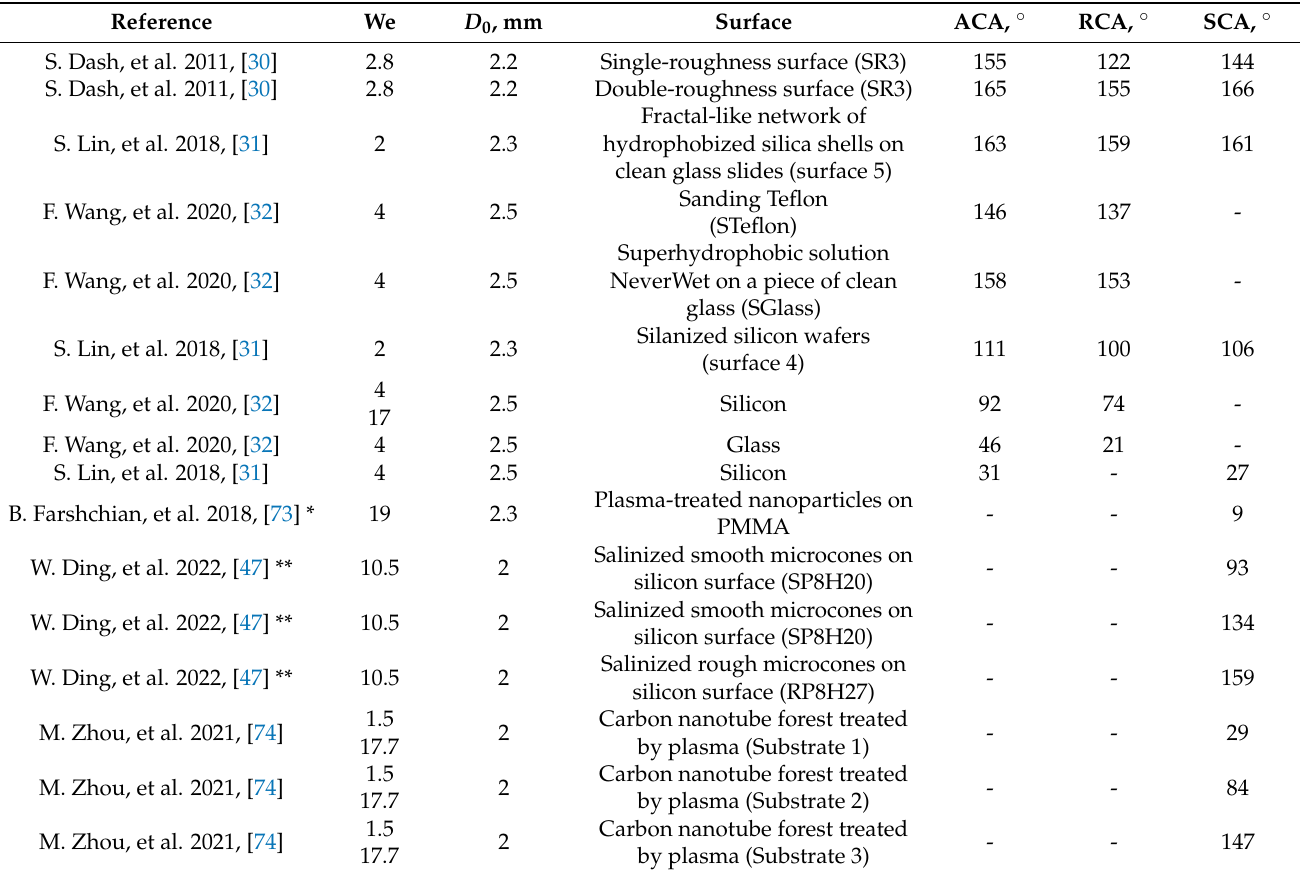
Table 2. References for comparing the dynamics of water droplet spreading on surfaces with different